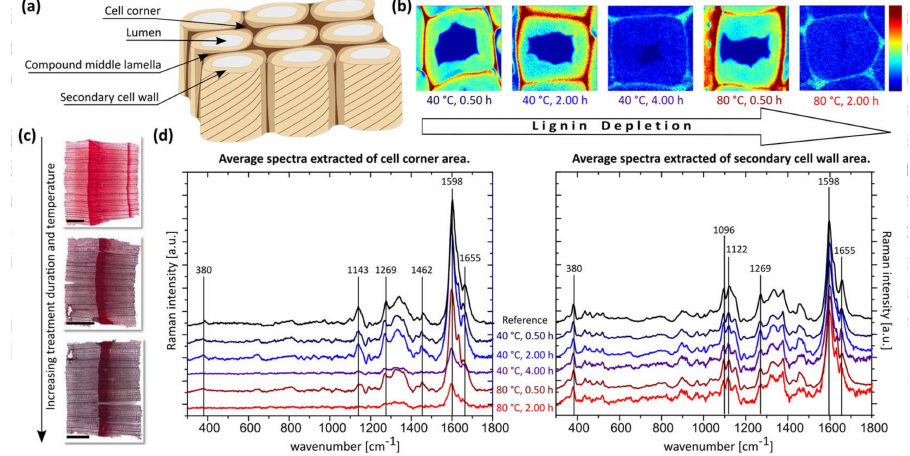
Figure 1. Characterization of soda pulped spruce wood cross sections. ( a ) Wood tissue model visualizing the main anatomical regions. ( b ) Raman images based on the integration of the main lignin band at 1598 cm − 1 (all images are identically scaled). ( c ) Staining of spruce wood cross sections (scale bar = 1 mm). ( d ) Calculated average spectra, extracted from the secondary cell wall region and cell corner area (all cell wall spectra are normalized on the band at 380 cm − 1